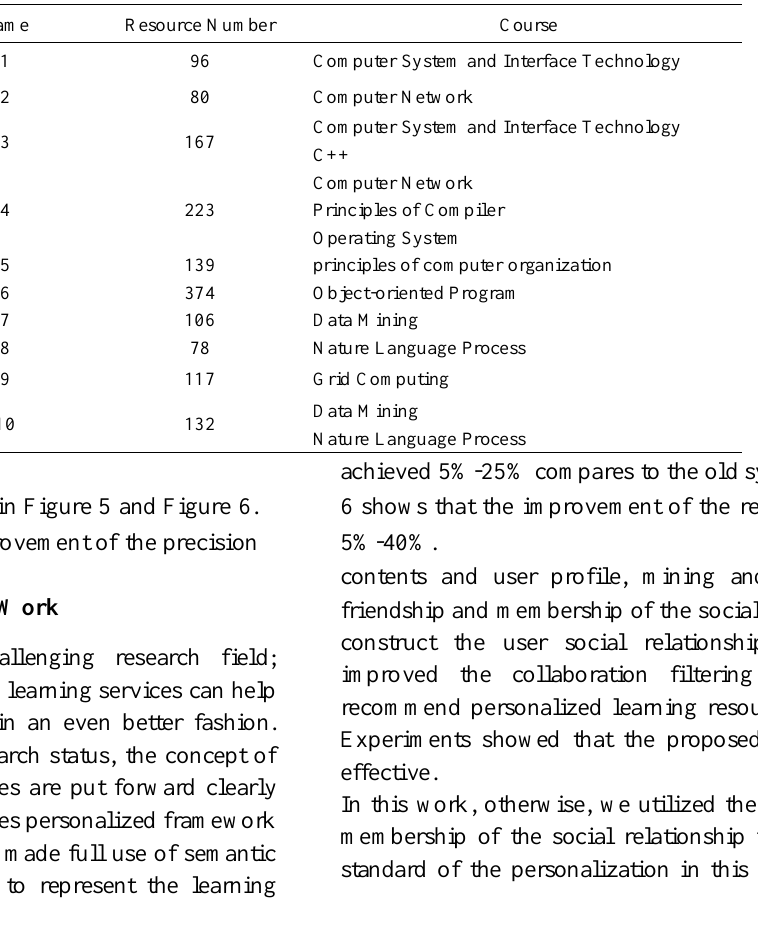
Table 1. The number of resources in the user